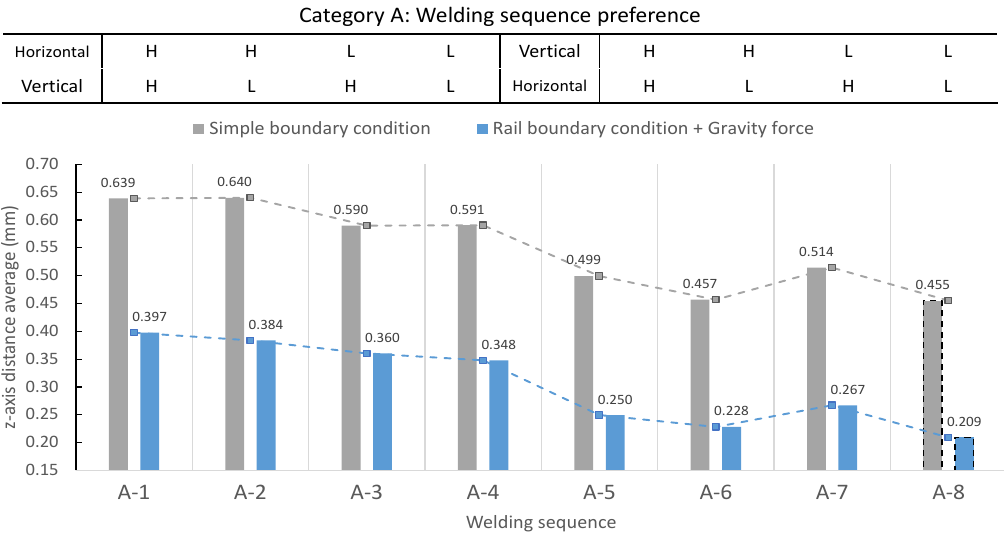
Figure 12. A distance of Category A under two di ff erent boundary Figure 12. 𝐴 𝑑𝑖𝑠𝑡𝑎𝑛𝑐𝑒 of Category A under two different boundary condition.